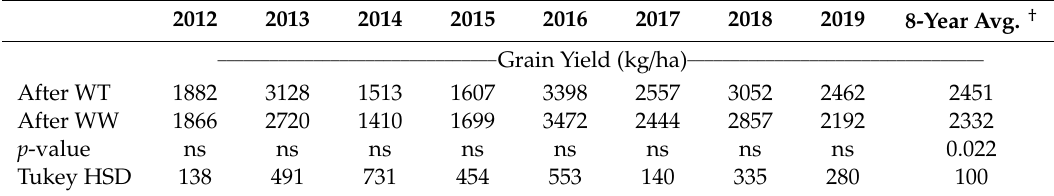
Table 5. Spring wheat grain yield grown in a 3-year rotation after winter triticale (WT) or after winter wheat